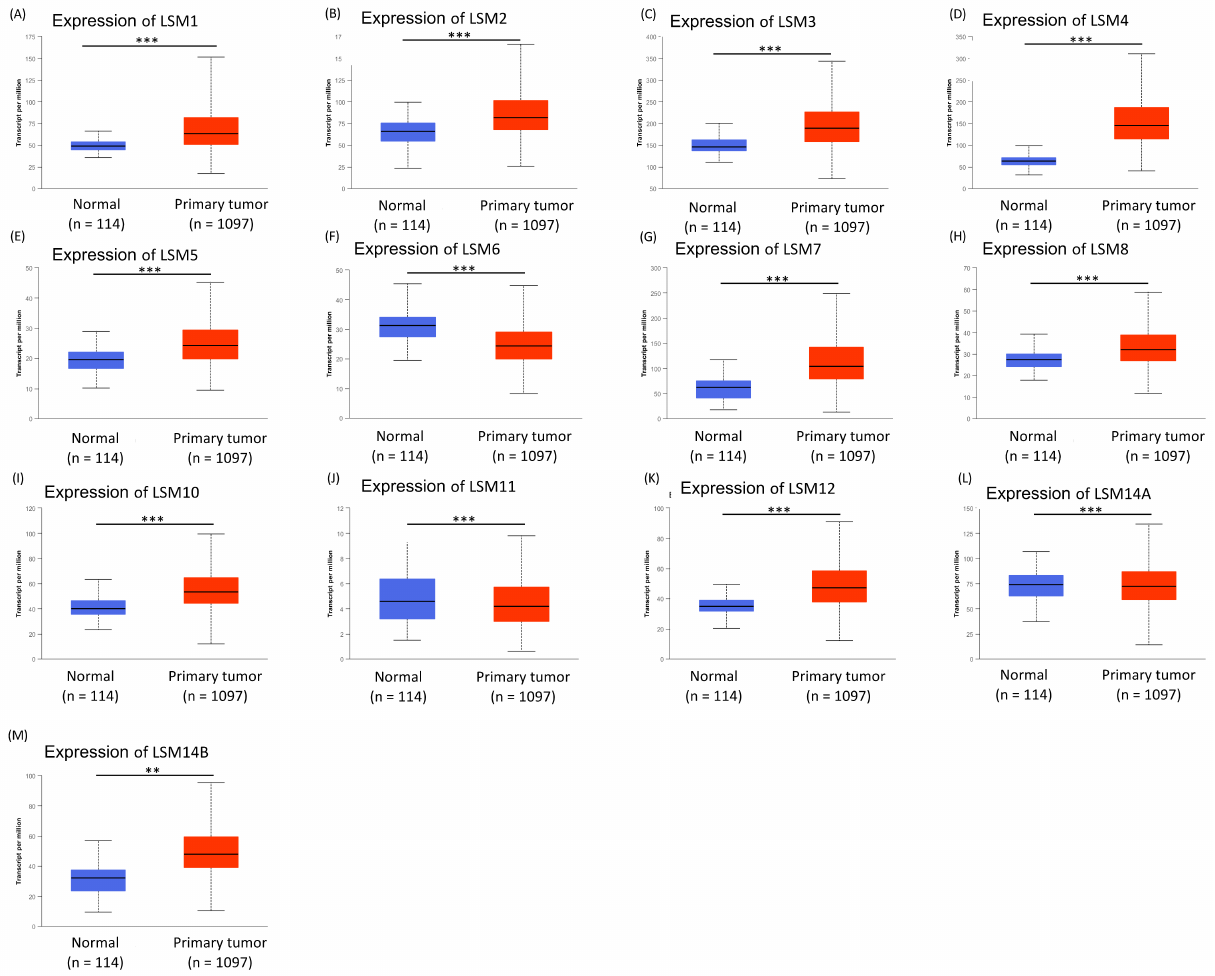
Figure 1. LSMs expressions in patients with breast cancer versus healthy controls (UALCAN database, with 114 normal samples and 1097 primary tumor samples). p -value < 0.05 was considered statistically significant by applying Student’s t -test. ( A – M ) represented the comparison of gene expression between the normal sample and primary tumor of LSM1~LSM14B, respectively. ** p < 0.01; *** p <